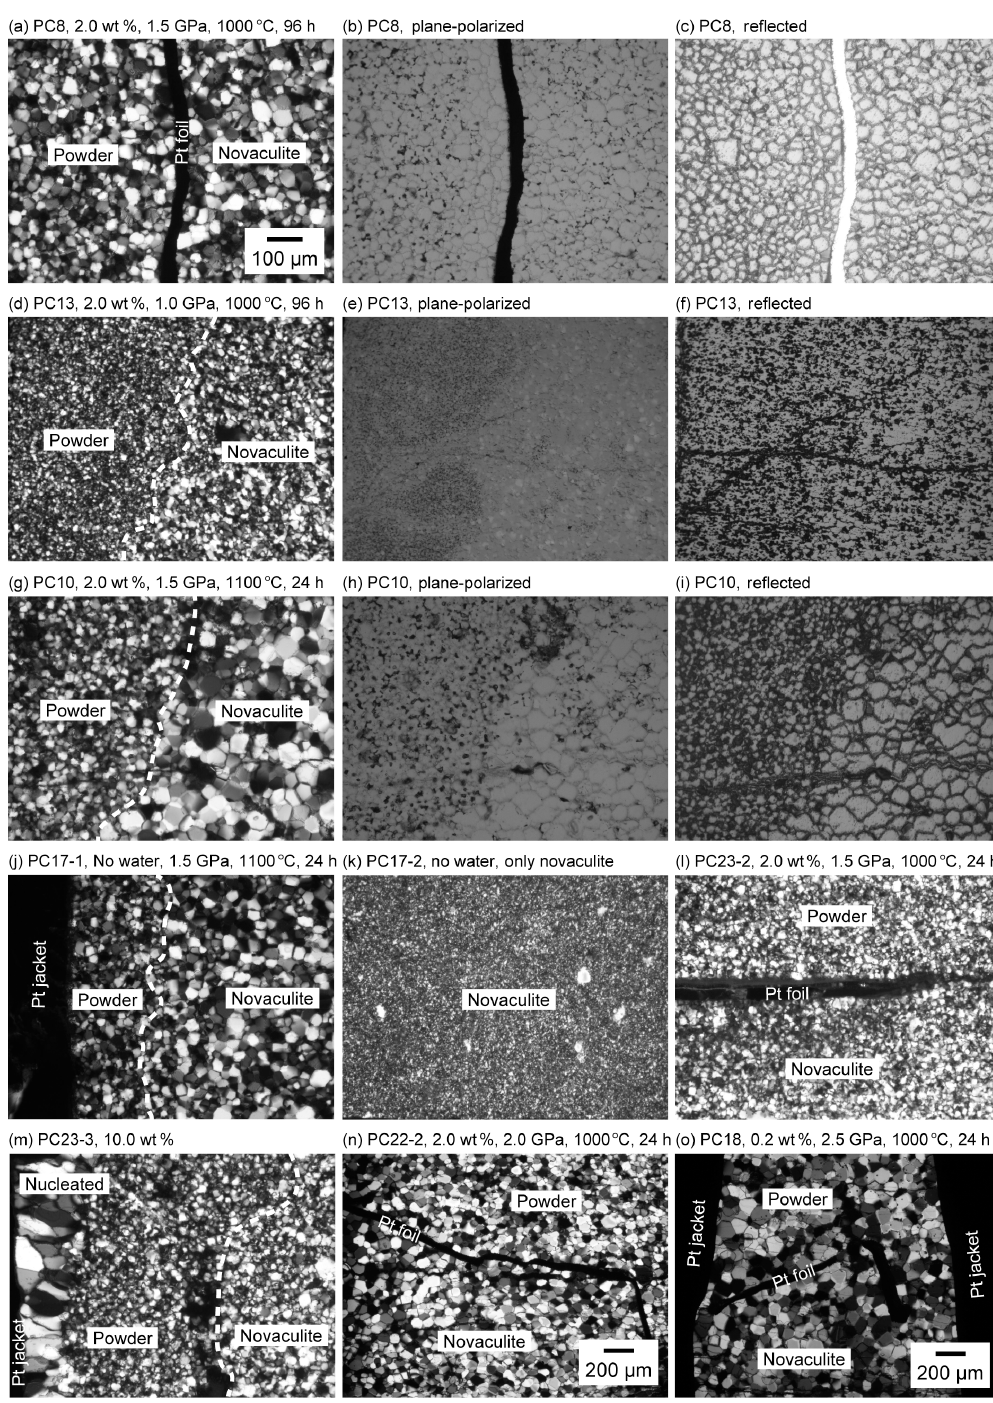
Figure 4. Light photomicrographs of the samples after experiments. Photos taken under plane-polarized or reflected light are labeled as such. The other photos were taken under cross-polarized light. Boundaries between the quartz powder and novaculite samples are marked by Pt foils or dashed lines. The magnification for photos without scale bars is the same as that for ( a ).